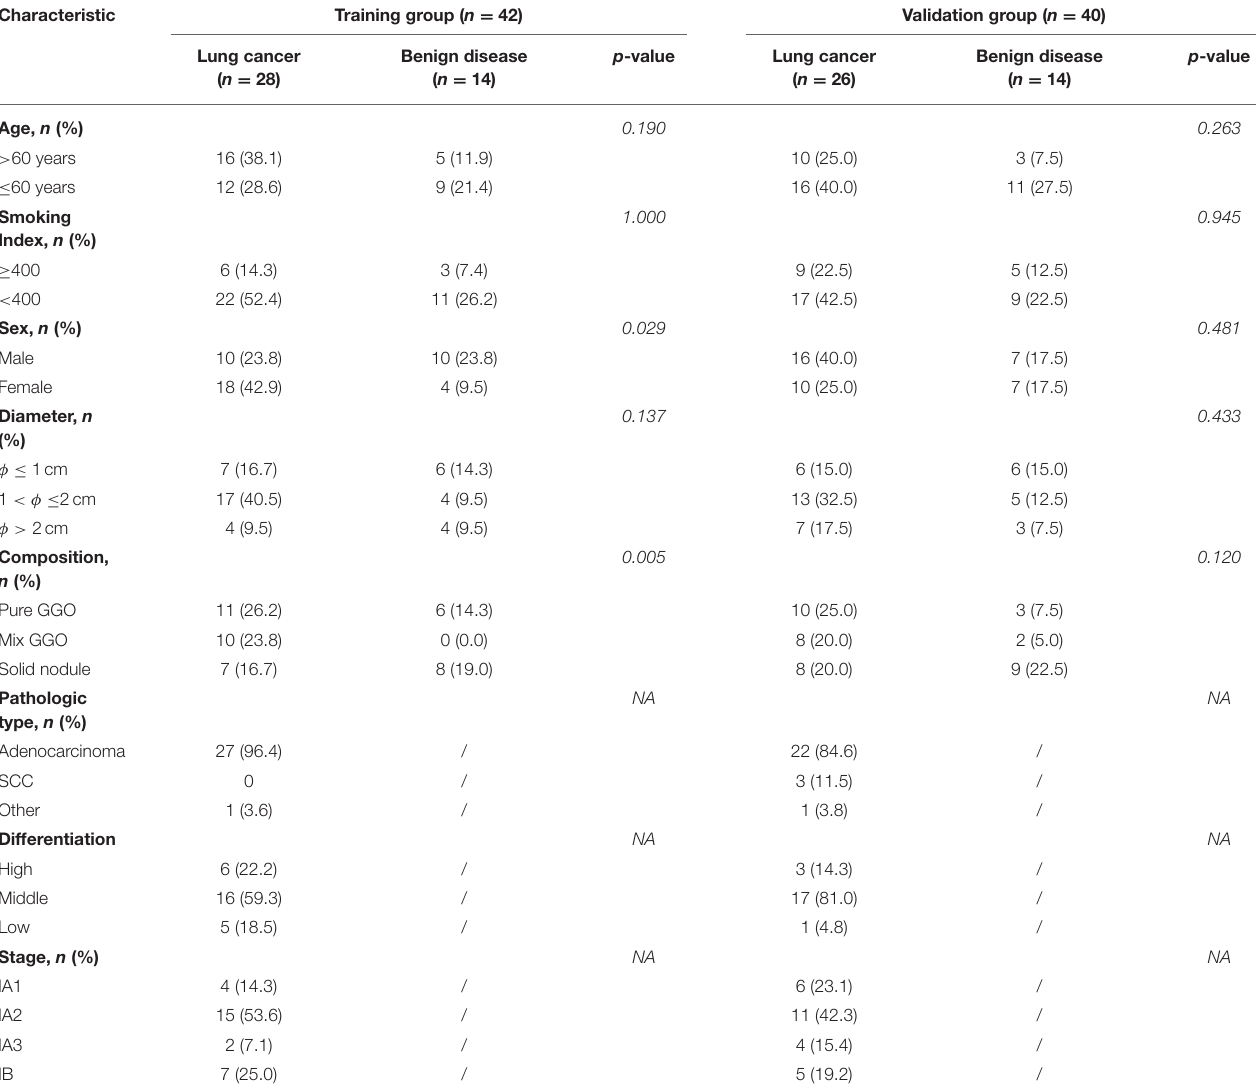
TABLE 1 | Clinicopathological characteristics of the study population. Characteristic Training group ( n =